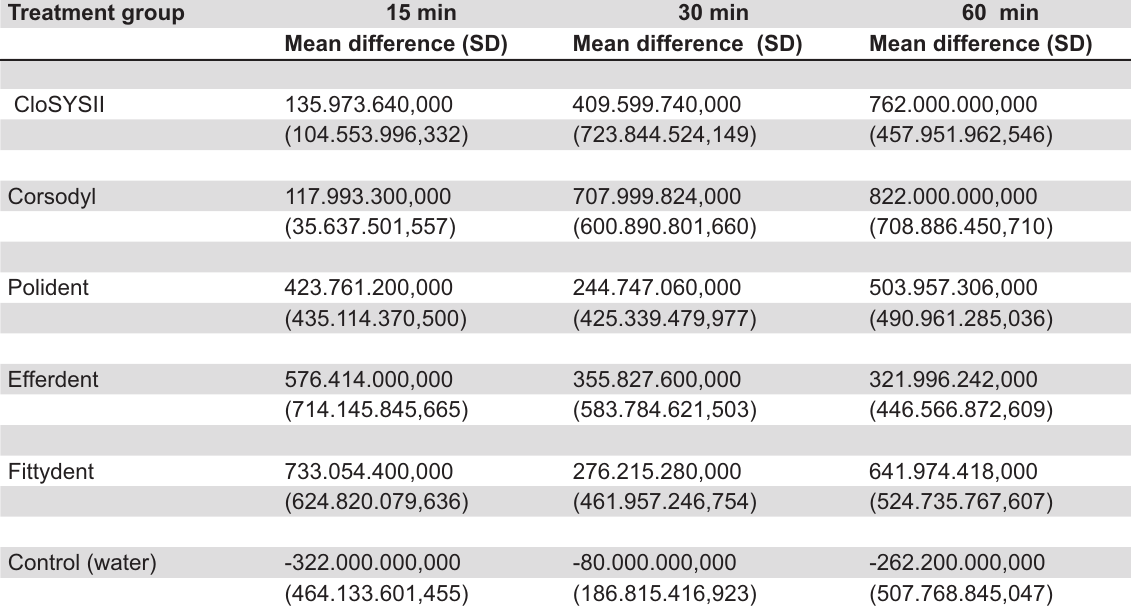
Table 1- Mean difference* and Standard Deviation (SD) in number of Colony-Forming Units (CFU) of &'!($('",--. over the evaluation periods of 15, 30 and 60 min.